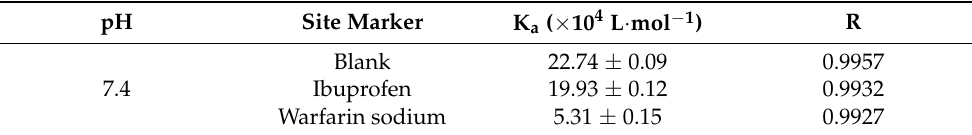
Table 3. Binding constants of competitive experiments in the complexation between astilbin and HSA. pH